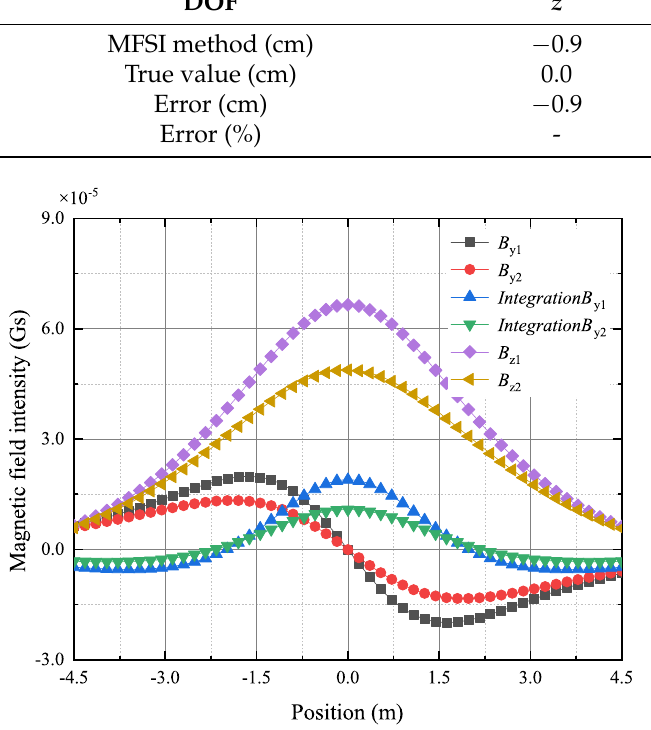
Figure 6. The radiated magnetic field of the transmitting coil in the normal case. B y1 , B z1 and B y2 , B z2 are y -axis and z -axis components of the magnetic field on the line ((0, 3, − 4.5), (0, 3, 4.5)) and ((0, 3.5, − 4.5), (0, 3.5, 4.5)) in meters, respectively. integrationB y1 and integrationB y2 are the integrals of B y1 and B y2